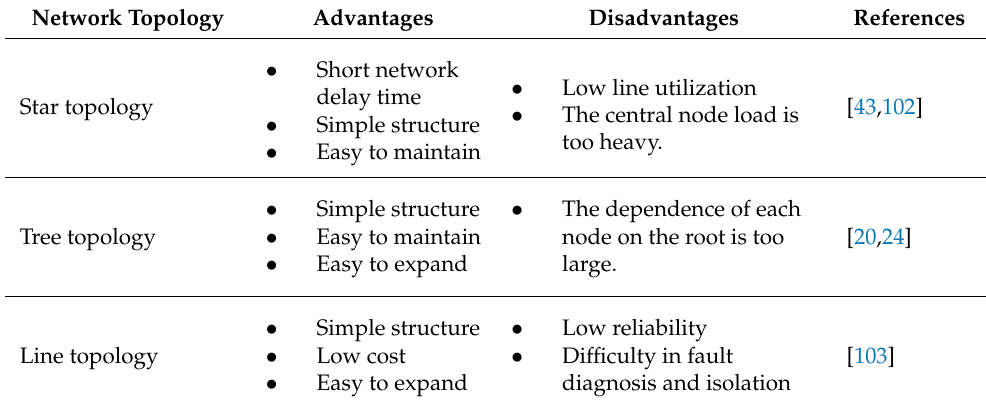
Figure 7. Network topology. ( a ) Tree topology. ( b ) Line topology. ( c ) Star topology. Table 8. Comparison of network topology. Table 8. Comparison of network